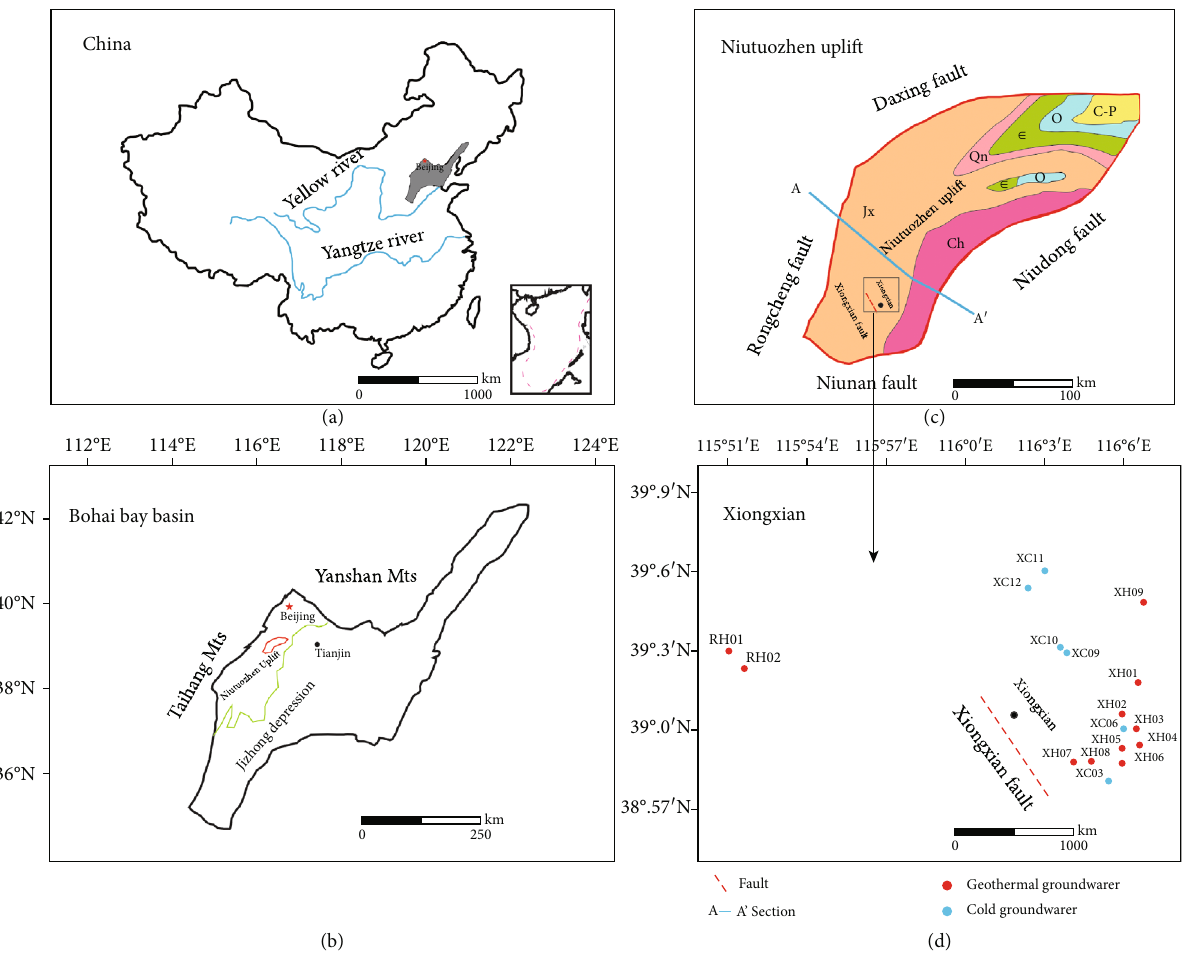
Figure 1: (a) Location of Bohai Bay Basin (BBB) in China; (b) location of Niutuozhen Uplift in the BBB; (c) location of Xiongxian geothermal sector in the Niutuozhen Uplift (cross section A – A ′ and the color legend are depicted in Figure 2); (d) location of all water samples including cold groundwater and geothermal